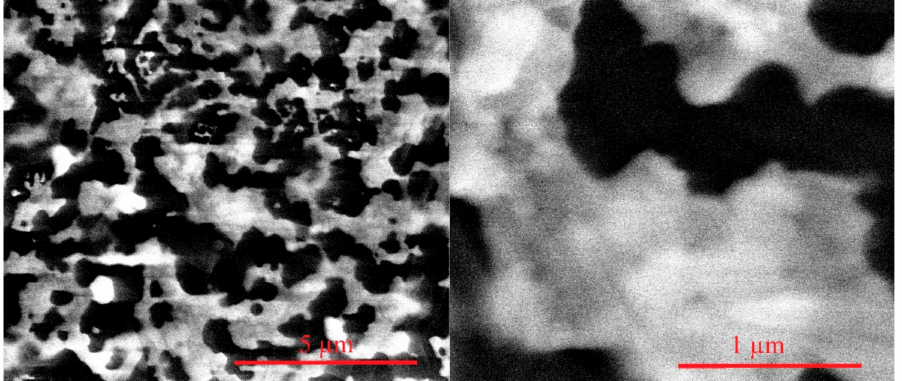
Figure 5. The SEM micrographs for the 5BeNa sample after the impedance measurements (gold electrodes, 25